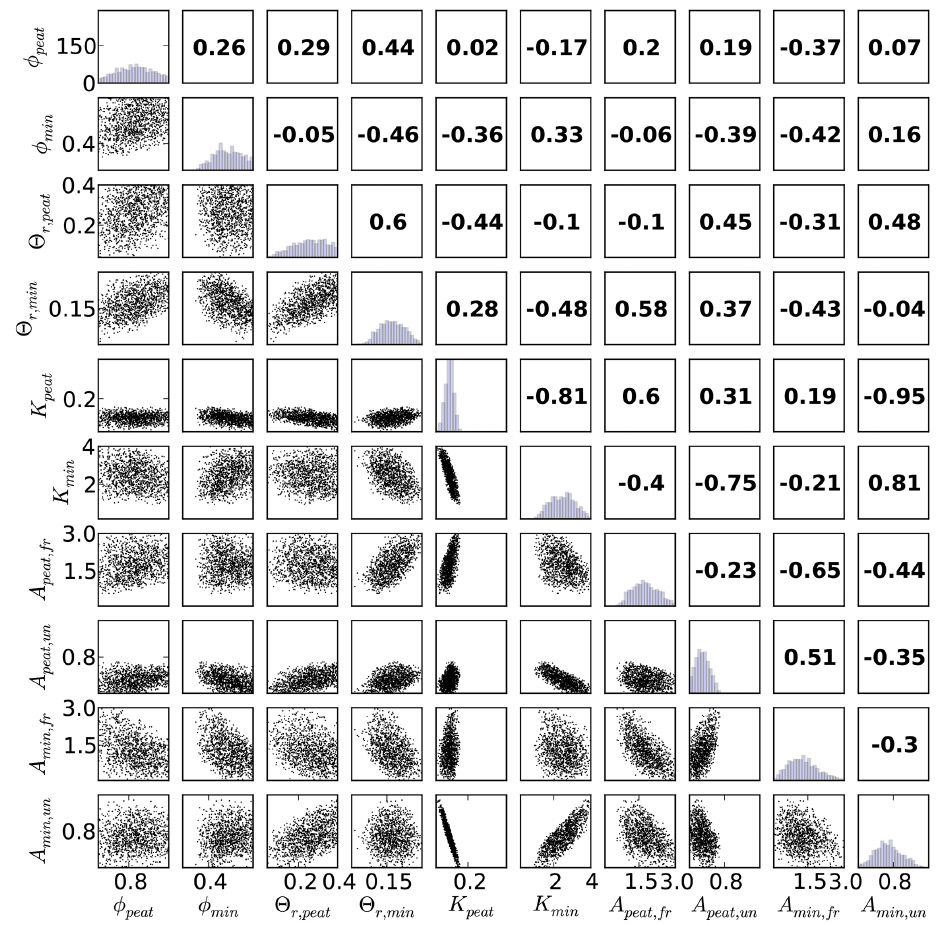
Figure 2. Matrix of paired plots of calibration-constrained hydrothermal soil parameter combinations obtained by NSMC sampling. Parame- ter histograms are plotted along the diagonal, paired scatterplots in the lower triangle (2-D projections of the null space), and Pearson (linear) correlation coefficients in the upper triangle. The histogram counts for all histograms are indicated along the ordinate axis of the upper left